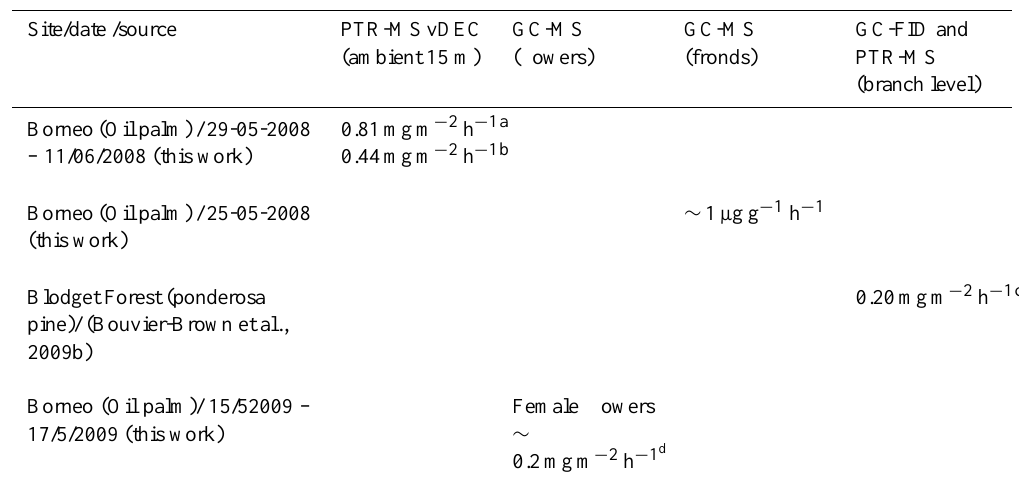
Table 2. Comparison of estragole fluxes.